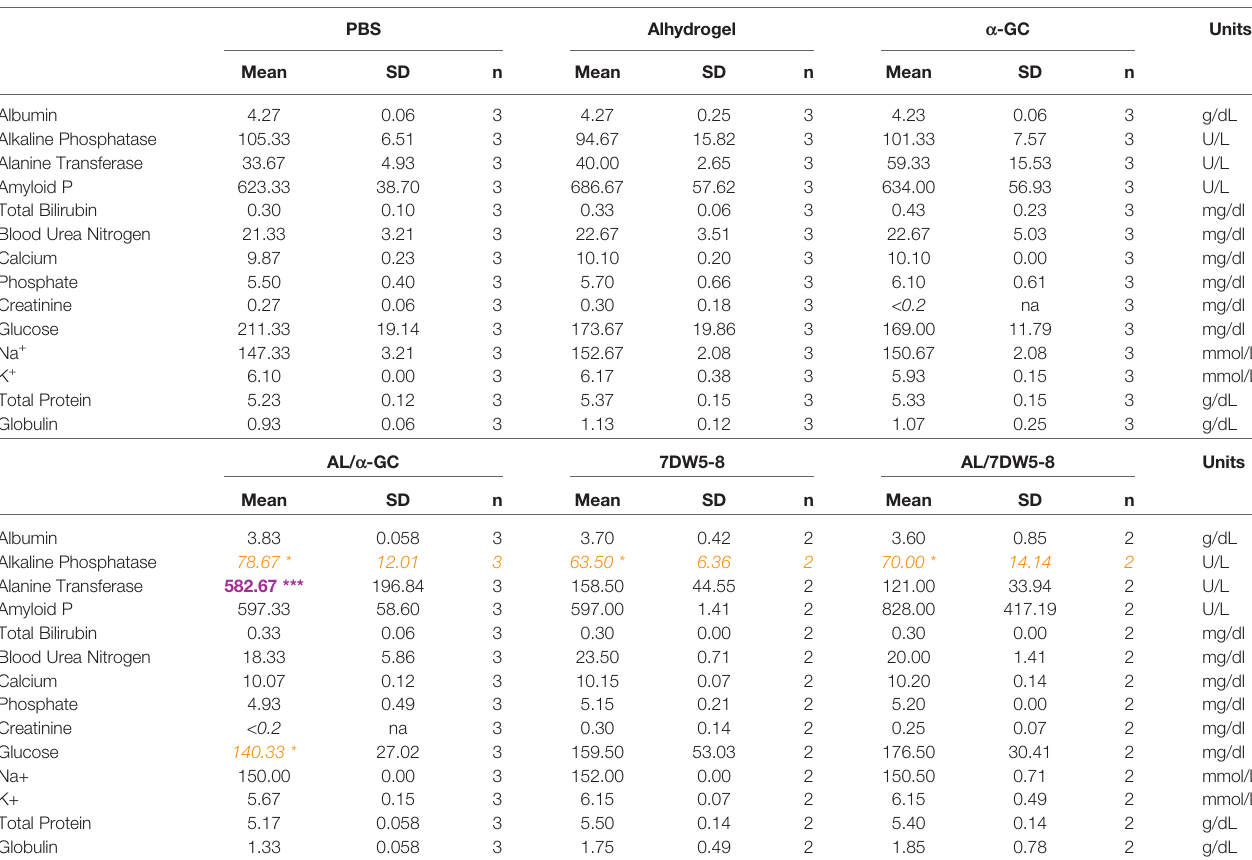
TABLE 1 | Blood analysis following administration of adjuvants singly and in combination. PBS